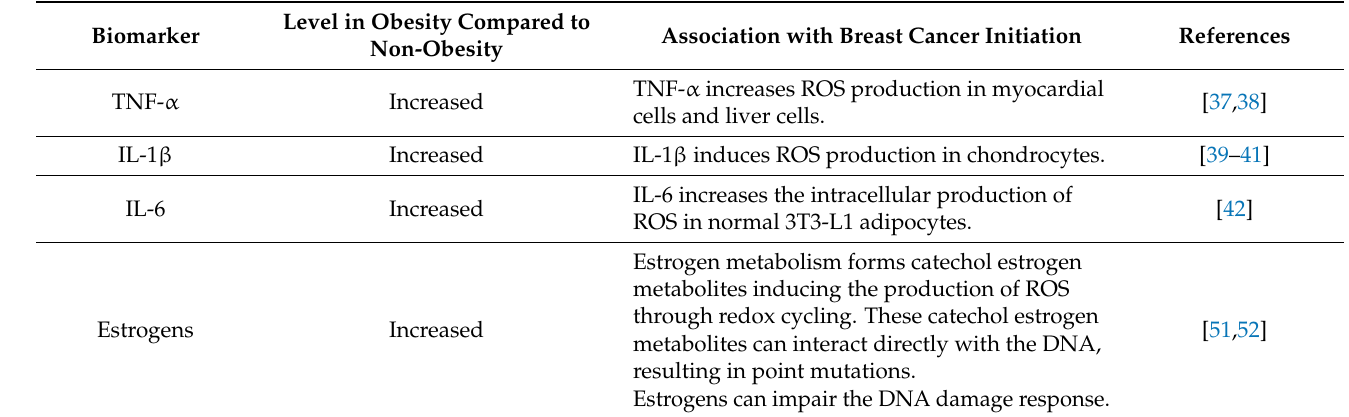
Table 1. Local obesity-associated biomarkers possibly involved in the initiation of breast